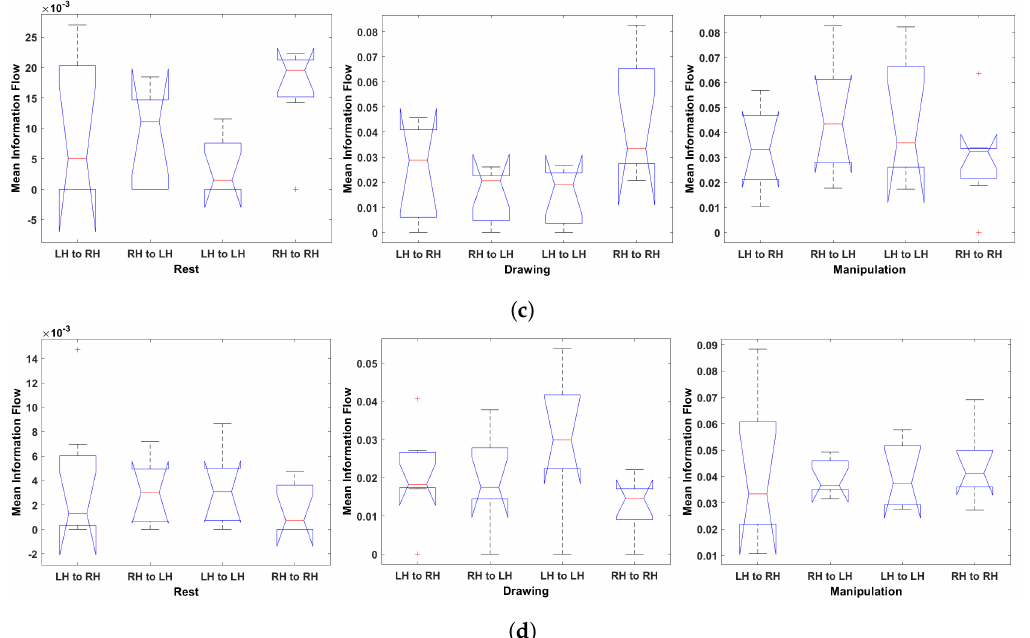
Figure 15. One-way ANOVA of Hemisphere-wise mean information flow during rest, drawing and manipulation states. ( a ) User 7 (Expert). ( b ) User 8 (Expert). ( c ) User 3 (Novice). ( d ) User 6 (Novice). Table 4. Result of pairwise mean difference using the t -test for hemispheres information flow during rest, drawing and manipulation